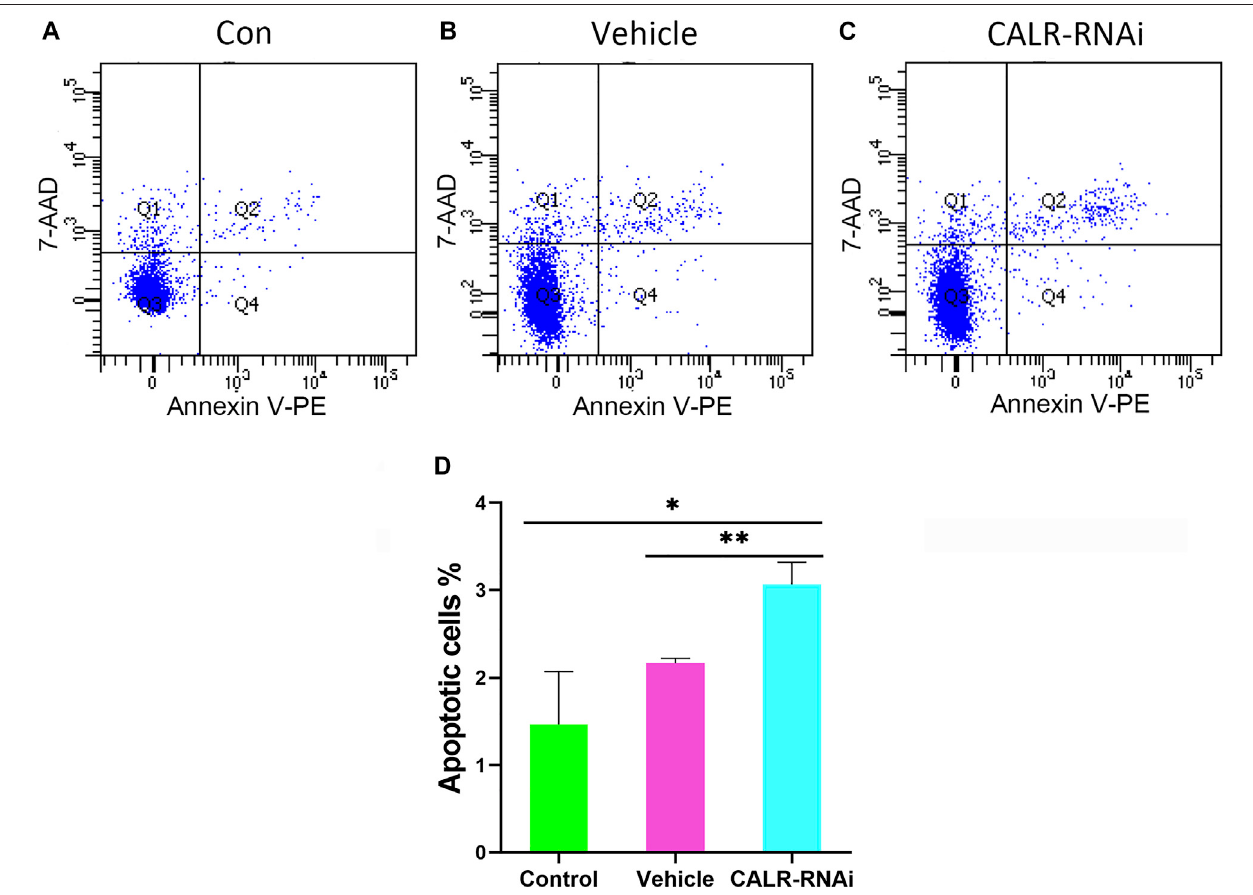
FIGURE 10 | Effects of CALR downregulation on AcPP cell apoptosis. (A – C) Cell apoptosis analysis using fl ow cytometry. (D) Percentage of apoptotic cells in the different groups; it is to be noted that the apoptotic rate in the CALR-RNAi group was signi fi cantly increased compared to that in the other groups. * p < 0.05 and ** p <